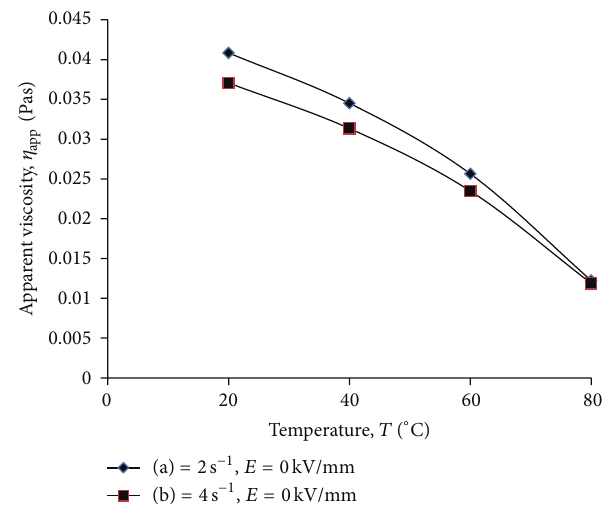
Figure 2: Viscosity (Pas) versus temperature, ( ∘ C) for (a) = 2 s −1 , 𝐸 = 0 kV/mm, and (b) = 4 s −1 , 𝐸 = 0 kV/mm.